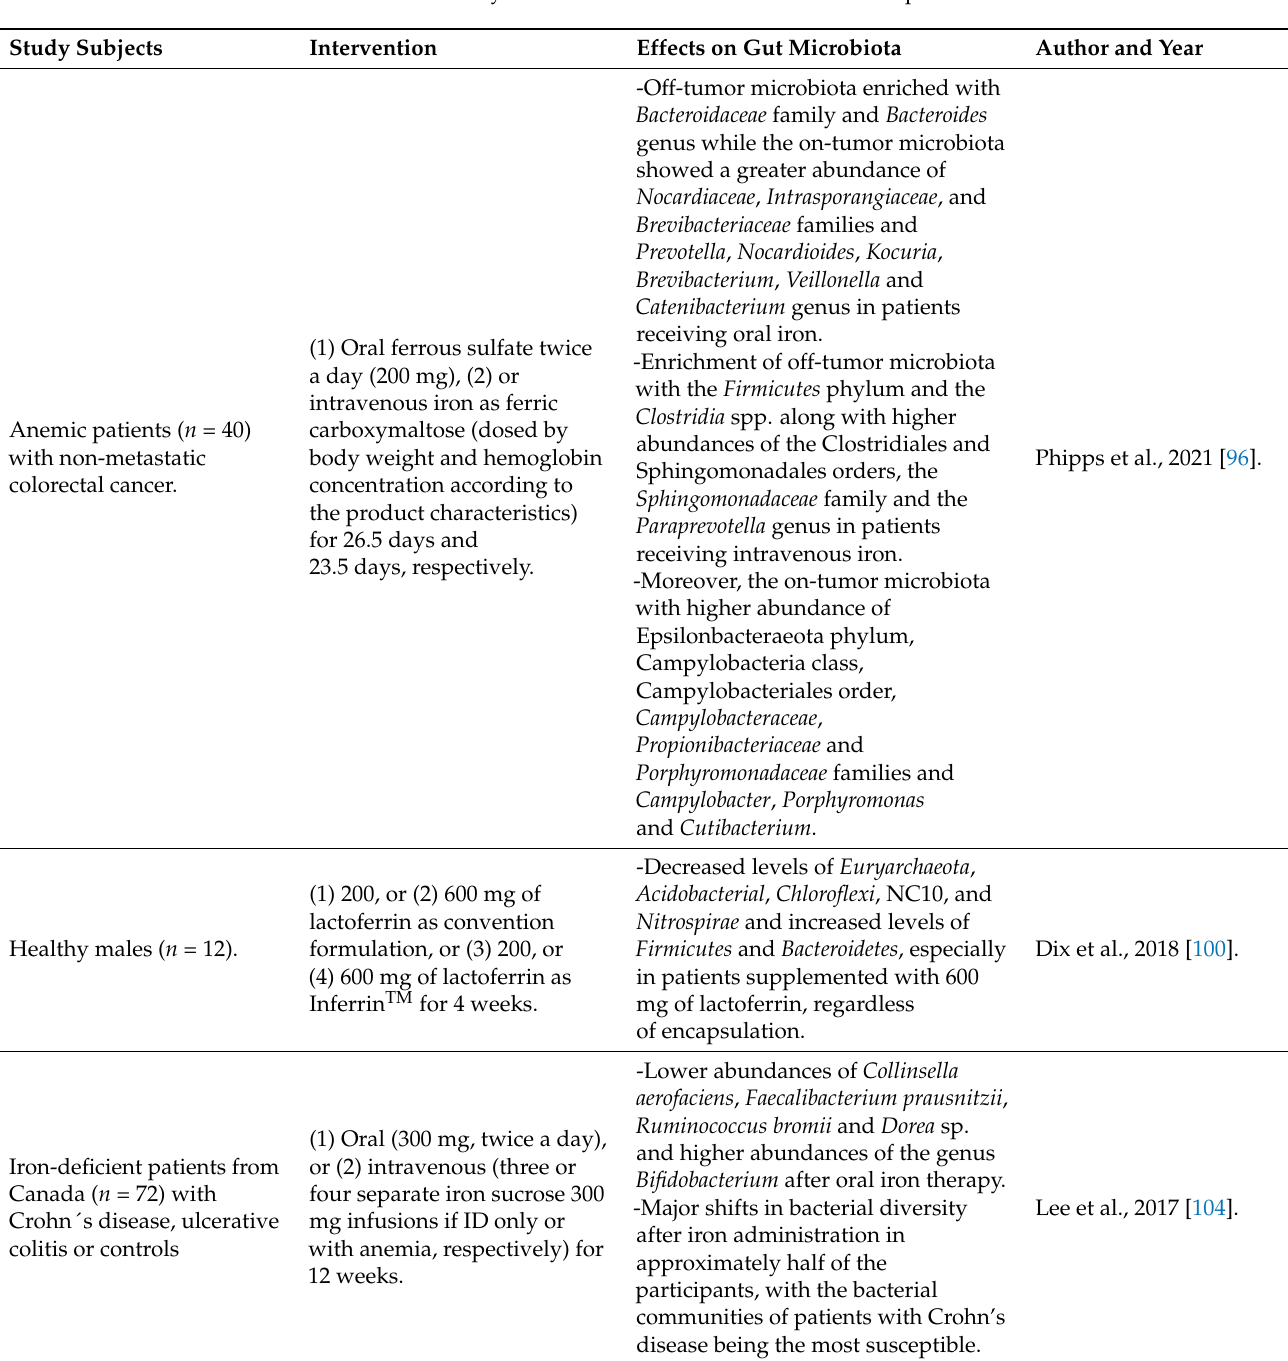
Table 3. Summary of the effects of the intervention studies performed in adults on